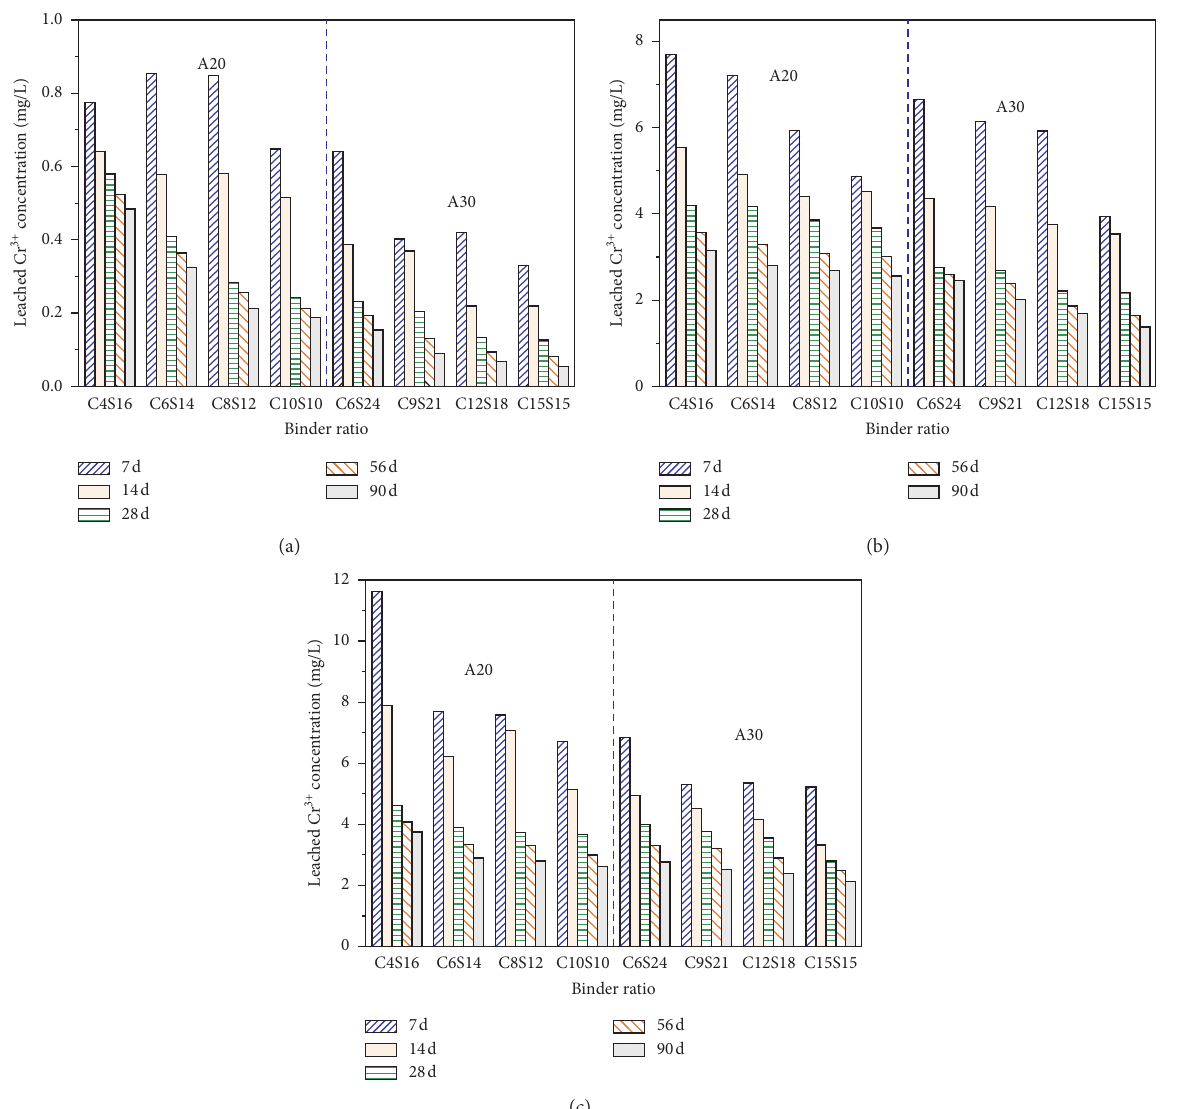
Figure 6: Evolutions of the leached Cr 3+ concentration with binder ration of the stabilized Cr-contaminated soils: (a) Cr0.1, (b) Cr0.5, and (c)